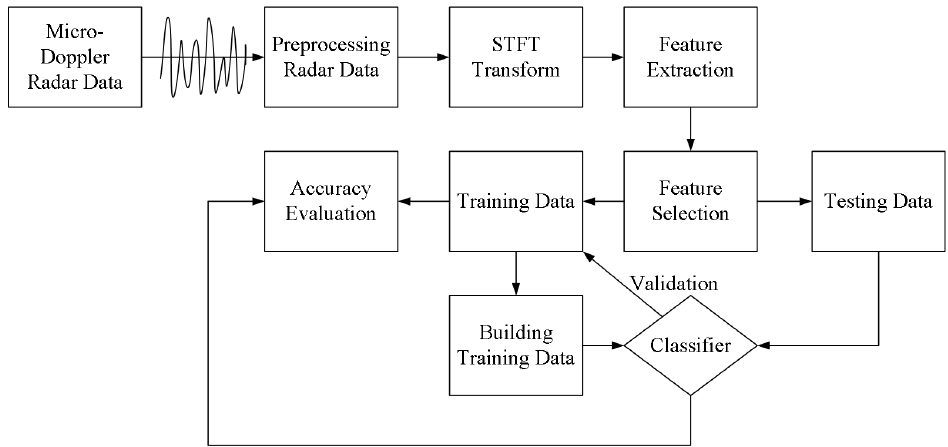
Figure 2. The structure of human pose classification and